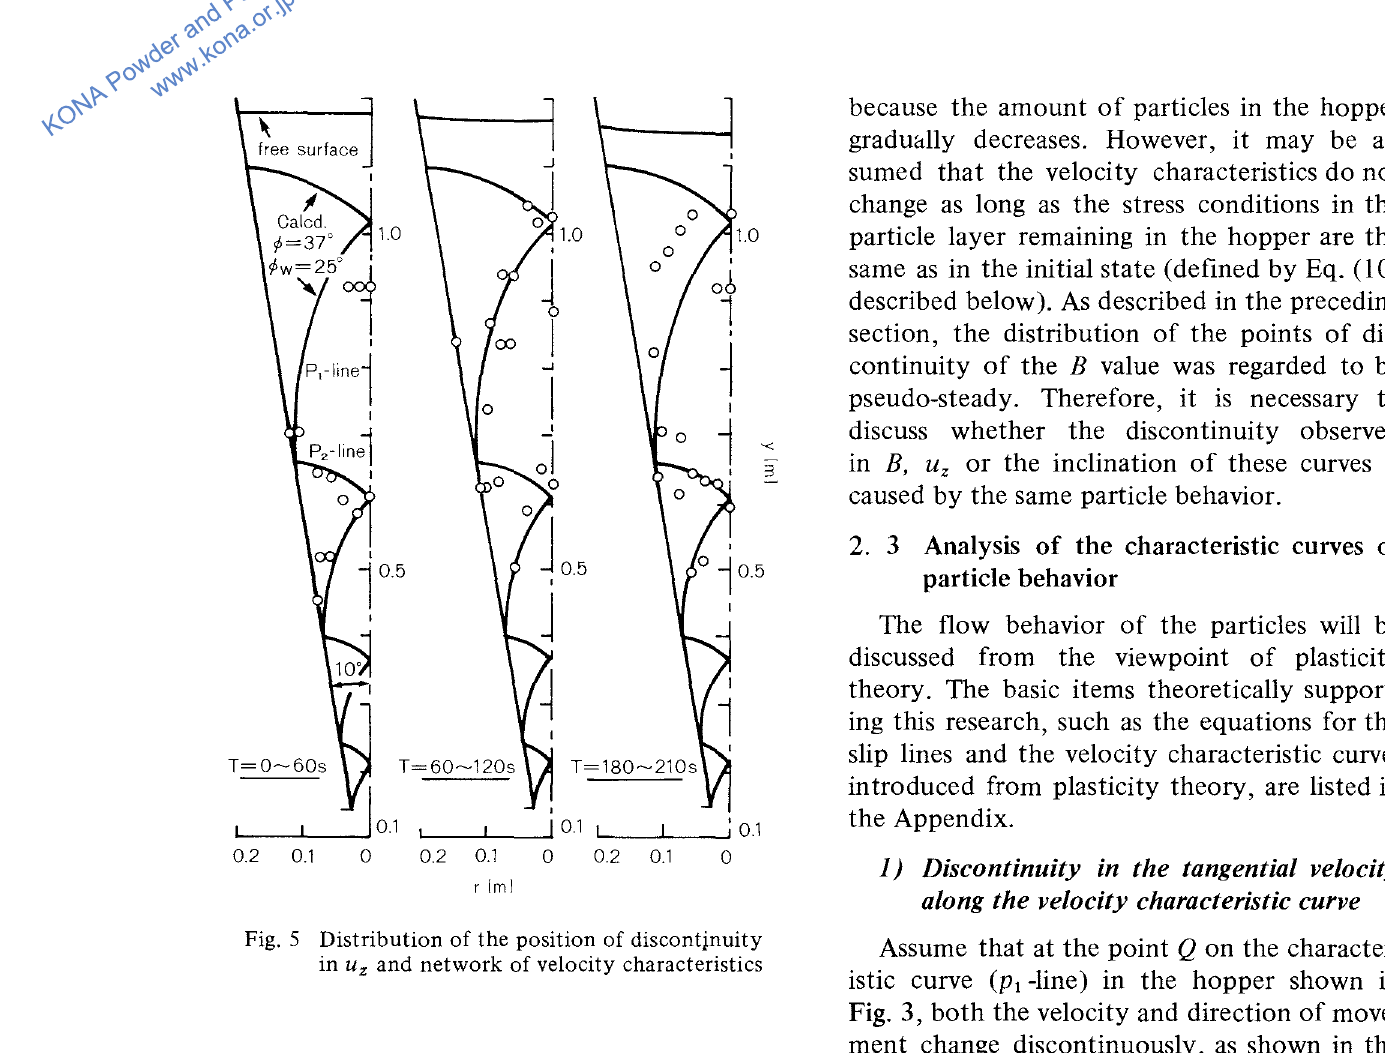
in Uz appeared at y = 0.4 to 0.5 m. The broken lines in Fig. 4 indicate the positions where Uz or auzfay changes discontinuously. The same tions, excluding the positions shown in Fig.